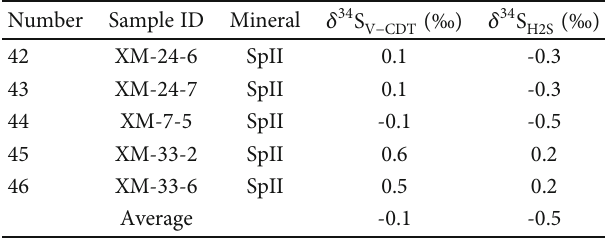
Table 1: Sulfur isotope data of sul fi de minerals from the Xinmin deposit.